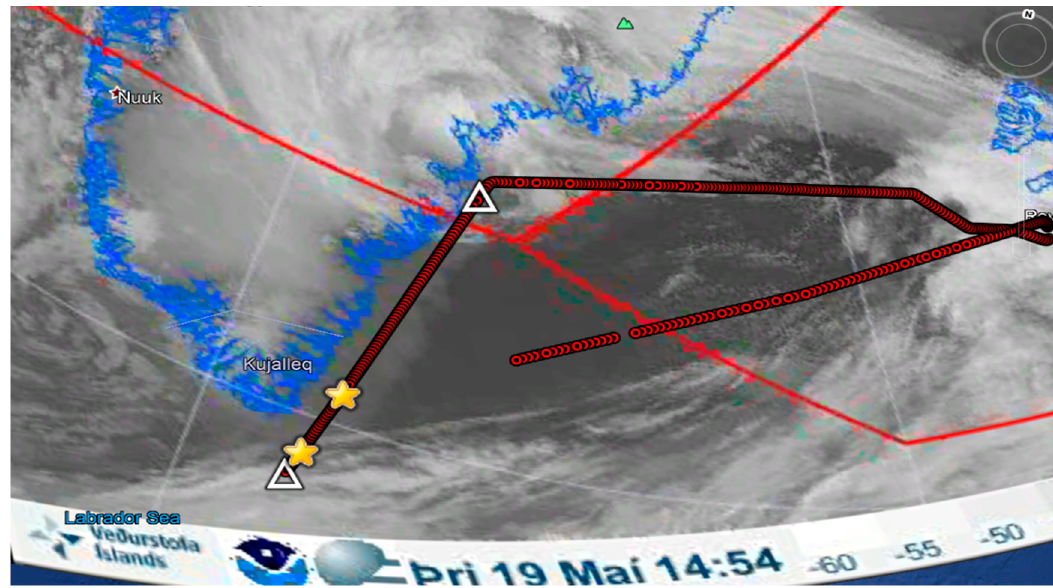
Figure 24. Flight track and DAWN profile locations (red dot) and dropsonde locations (gold star) during the 19 May 2015 flight mission. Start and end of leg used for cross-section denoted by white triangle. IR satellite imagery from MSG-SEVIRI near15Z (Google Earth). Image processed by the Icelandic Meteorological Office.